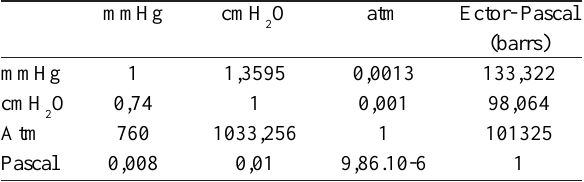
Tabela 1. Fatores de conversão entre diferentes unidades.